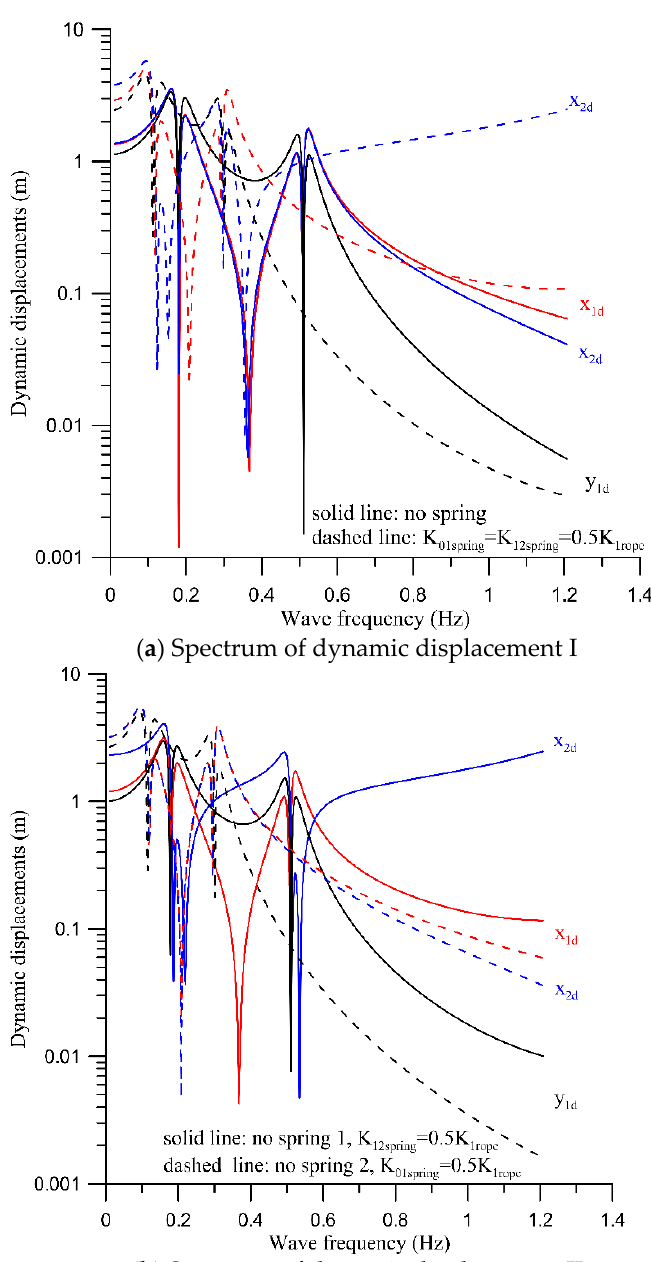
Figure 6. Effects of the buffer spring connecting to the ropes and the wave frequency f on the dynamic displacements of the system, { x 1 d , x 2 d , y 1 d } . [ A BB = 7 m 2 , θ 1 = 40 ◦ , m ef f , x = 6.038 tons, m ef f , y = 9.714 tons, L 1 = 1929.1 m, other parameters are the same as those in Figure